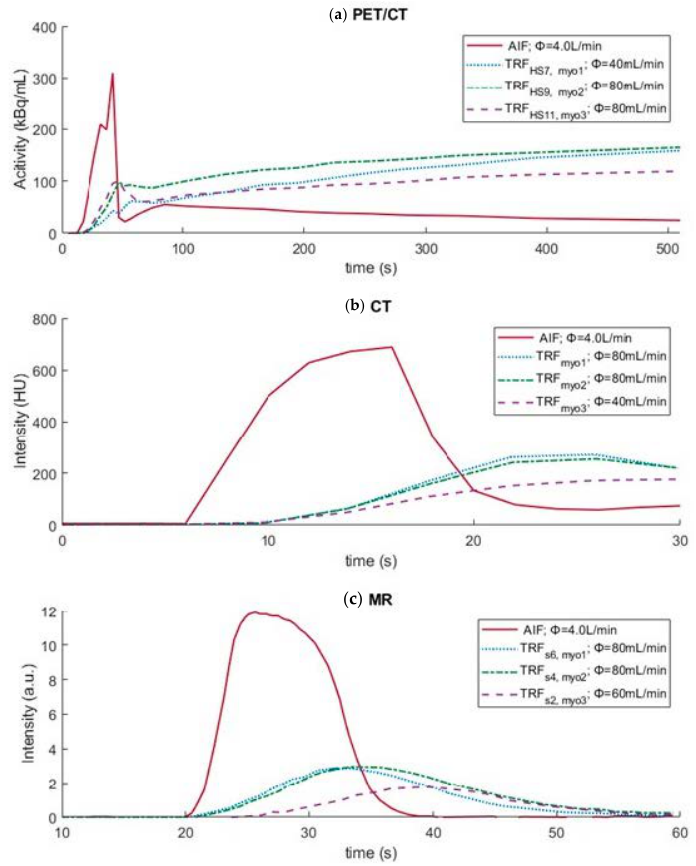
Figure 7. Example time activity/intensity curves for ( a ) PET/CT, ( b ) CT, and ( c ) MR phantom measurements displaying the arterial input function (AIF) and regional tissue response functions (TRFs). For PET/CT, these regions comprised heart segments (HS) 7, 9, and 11, which matched the center of the three phantom myocardial regions (myo1 ‒ 3). For CT these regions comprised myo1 ‒ 3 in its total (manually delineated), and for MR the segments (s) comprised parts of myo1 ‒ 3. Note: the x-axes have different time scales.